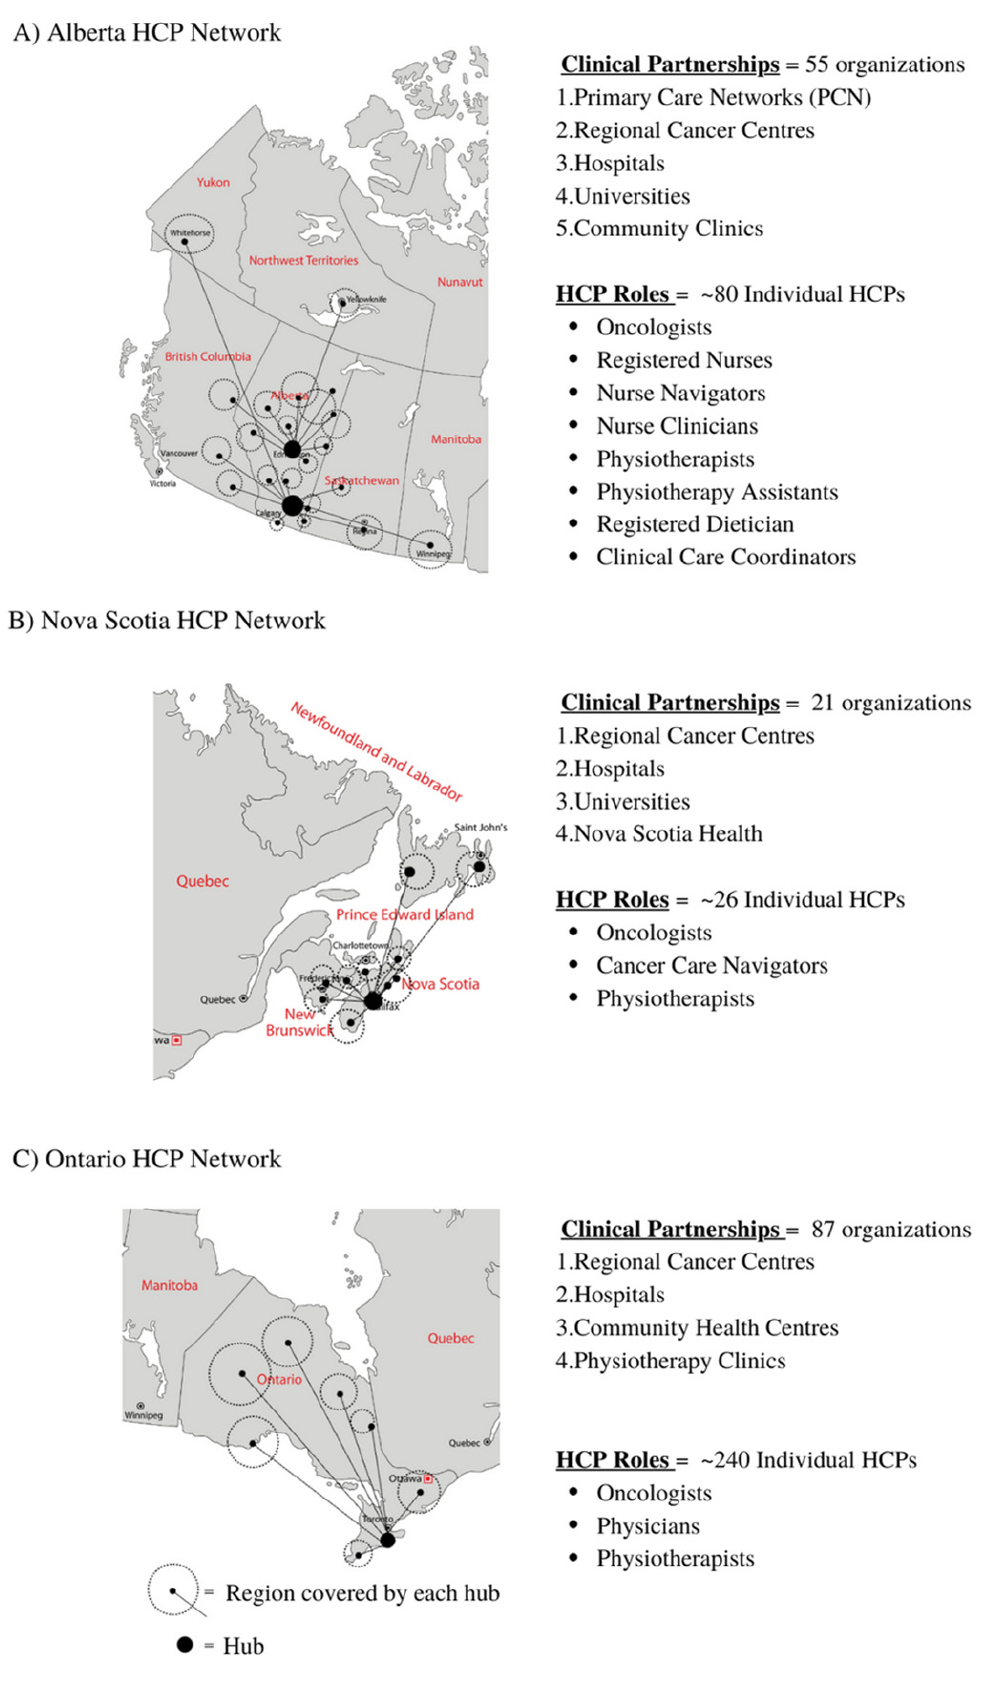
Figure 3. ( A – C ): EXCEL regional HCP networks.